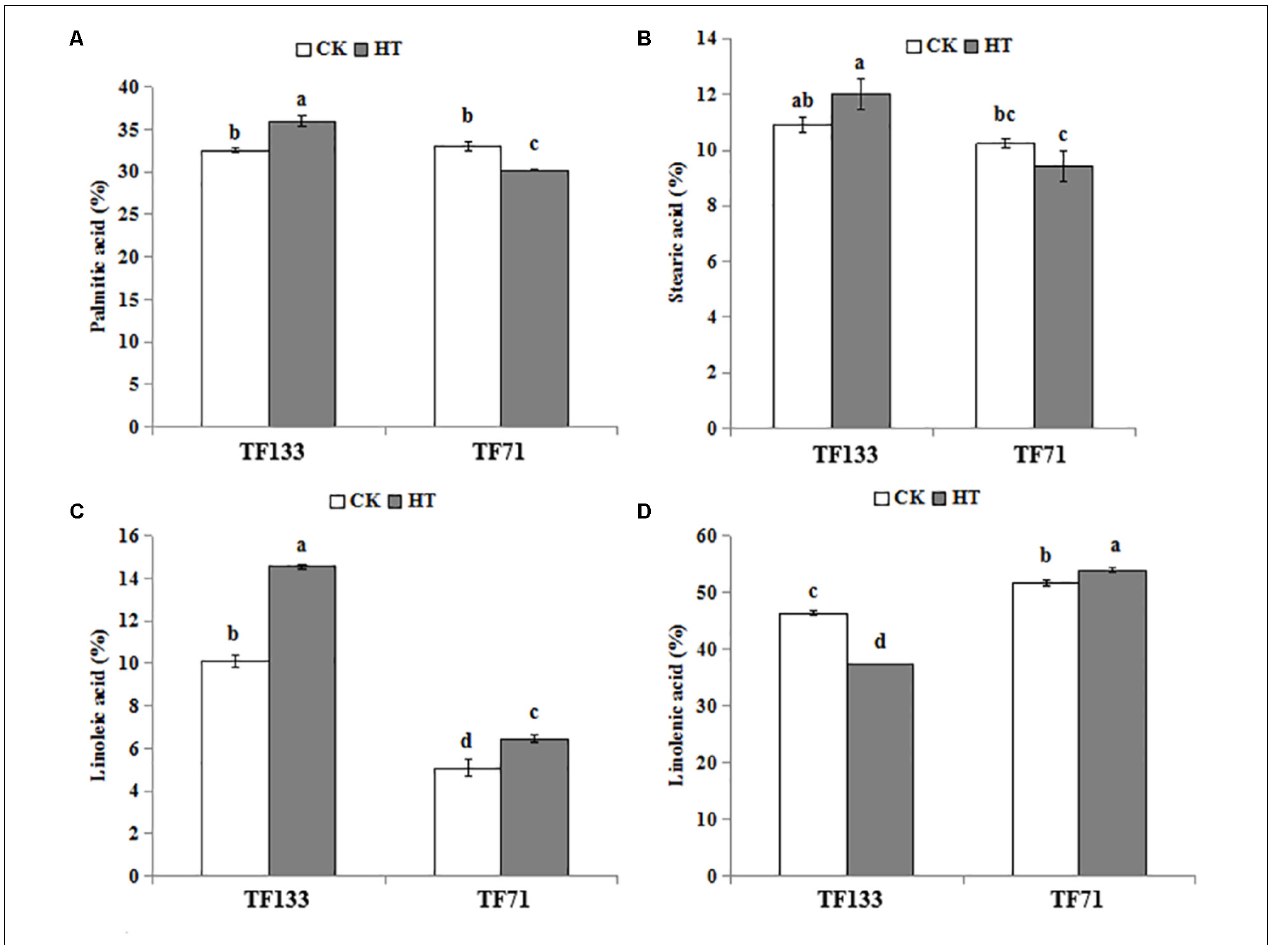
FIGURE 4 | Changes of four major fatty acids in tall fescue leaves in heat-sensitive genotype “TF133” and heat-tolerant genotype “TF71” under normal conditions or heat stress. (A) Palmitic acid. (B) Stearic acid. (C) Linoleic acid. (D) Linolenic acid. CK was the control (22/18 ◦ C for light/dark), while HT was the heat treatment (40/35 ◦ C for light/dark). All the plants were treated for 1 day. Mean ± SD were calculated from five biological repeats. Different letters indicated statistical difference significance at P < 0.05 among the different treatments groups by Duncan’s multiple range